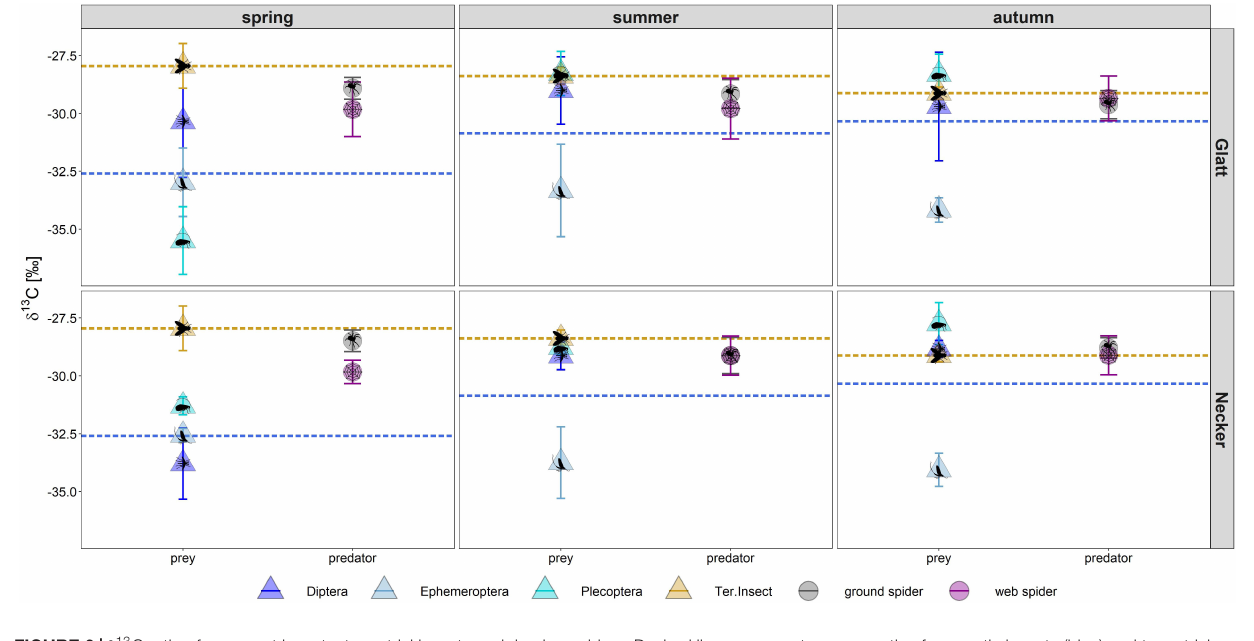
FIGURE 6 | δ 13 C ratio of emergent insects, terrestrial insects and riparian spiders. Dashed lines represent average ratios for aquatic insects (blue) and terrestrial insects (orange). Error bars represent standard deviations. For number of samples per group see Table 1 . To adjust for fractionation between trophic levels, TEF = 1.1 was subtracted from predator δ 13 C. On the left side of the plot are prey values, on the right site are predator values. (cid:104) TABLE 4 | δ 13 C, individual PUFA content (% of total fatty acids) and (cid:54) ω 3/ (cid:54) ω 6 ratio (mean ± standard deviation) in spiders at different distances from shore (site N4). distance δ 13 C LIN ALA ground